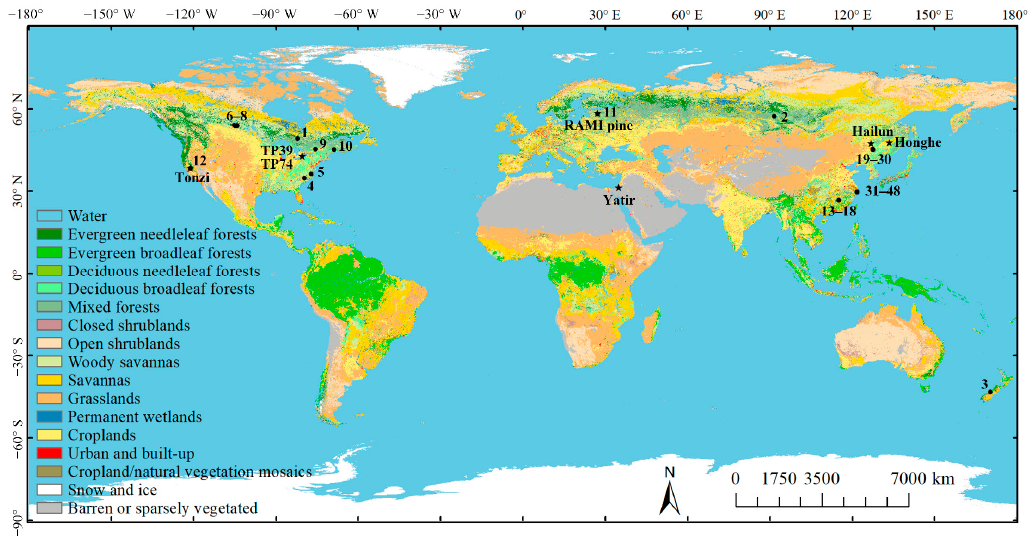
Figure 1. Distribution of collected field CI measurements for all IGBP classes at the global scale. The dots indicate 48 field-measured sites labeled with IDs listed in Table 1. The stars denote sites with dots indicate 48 field ‐ measured sites labeled with IDs listed in Table 1. The stars denote sites with seasonal profiles of field ‐ measured CIs labeled with names in Table 2. seasonal profiles of field-measured CIs labeled with names in Table